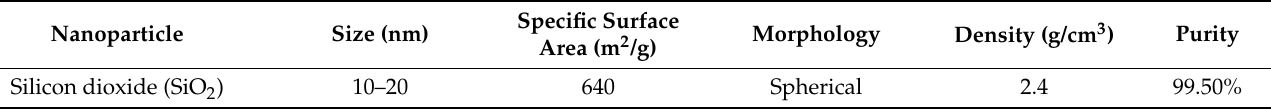
Table 5. Nanoparticle